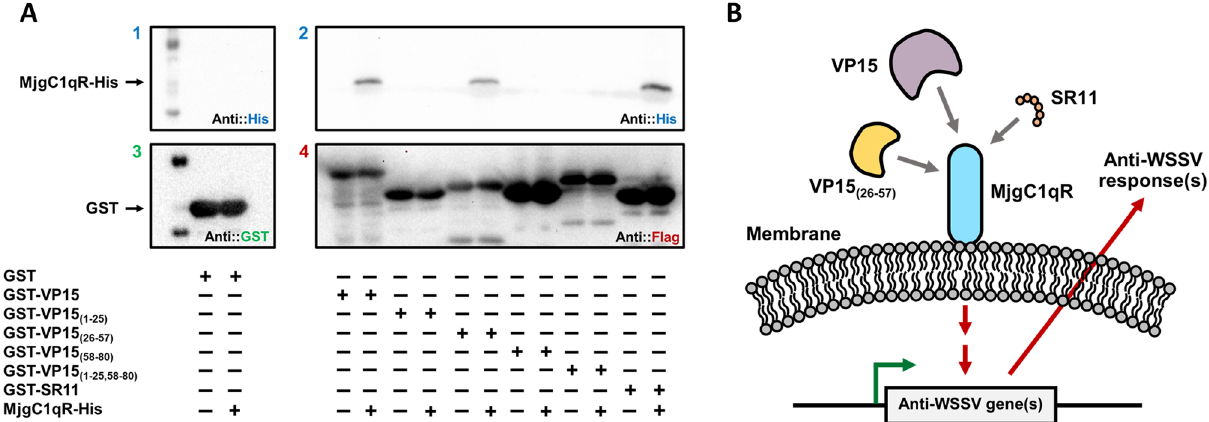
Figure 5. GST pull-down assay between MjgC1qR and GST-VP15, GST-VP15 (1–25) , GST-VP15 (26–57) , GST-VP15 GST-SR11 were observed via GST pull-down assay and confirmed by Western blot analysis with (1 and 2) anti- His antibody, (3) anti-GST antibody, and (4) anti-Flag antibody. The symbol “ + ” indicates the proteins used for the assay. ( B ) In shrimp, VP15, VP15 (26–57) , and SR11 interacted with the host gC1qR, hence inducing a cellular signaling cassette that could activate the transcription of antimicrobial